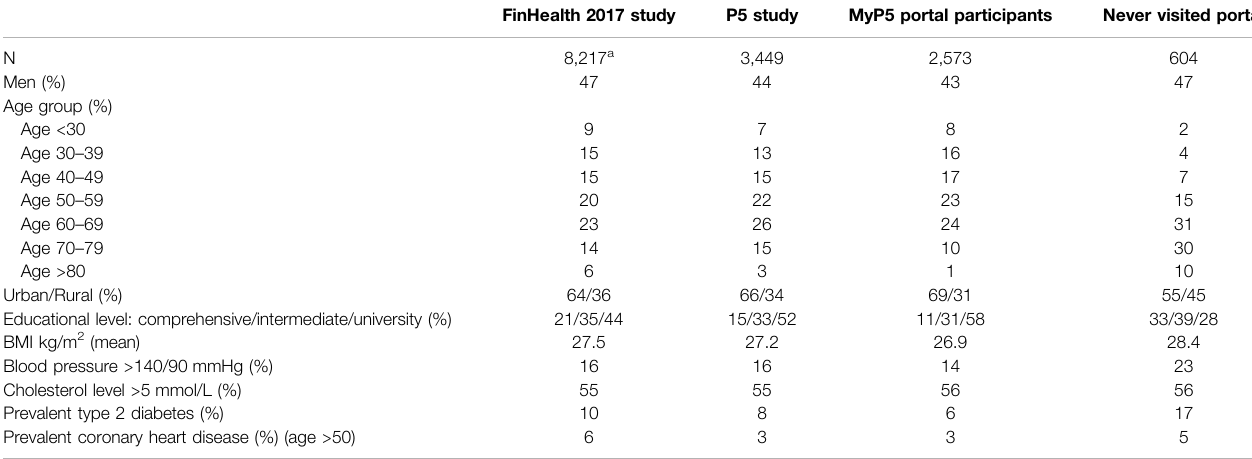
TABLE 1 | A comparison of participant characteristics between the FinHealth 2017 and P5 Studies. The information on FinHealth 2017 Study participants (age > 30) was obtained from FinHeath 2017 Study report (Koponen et al.,